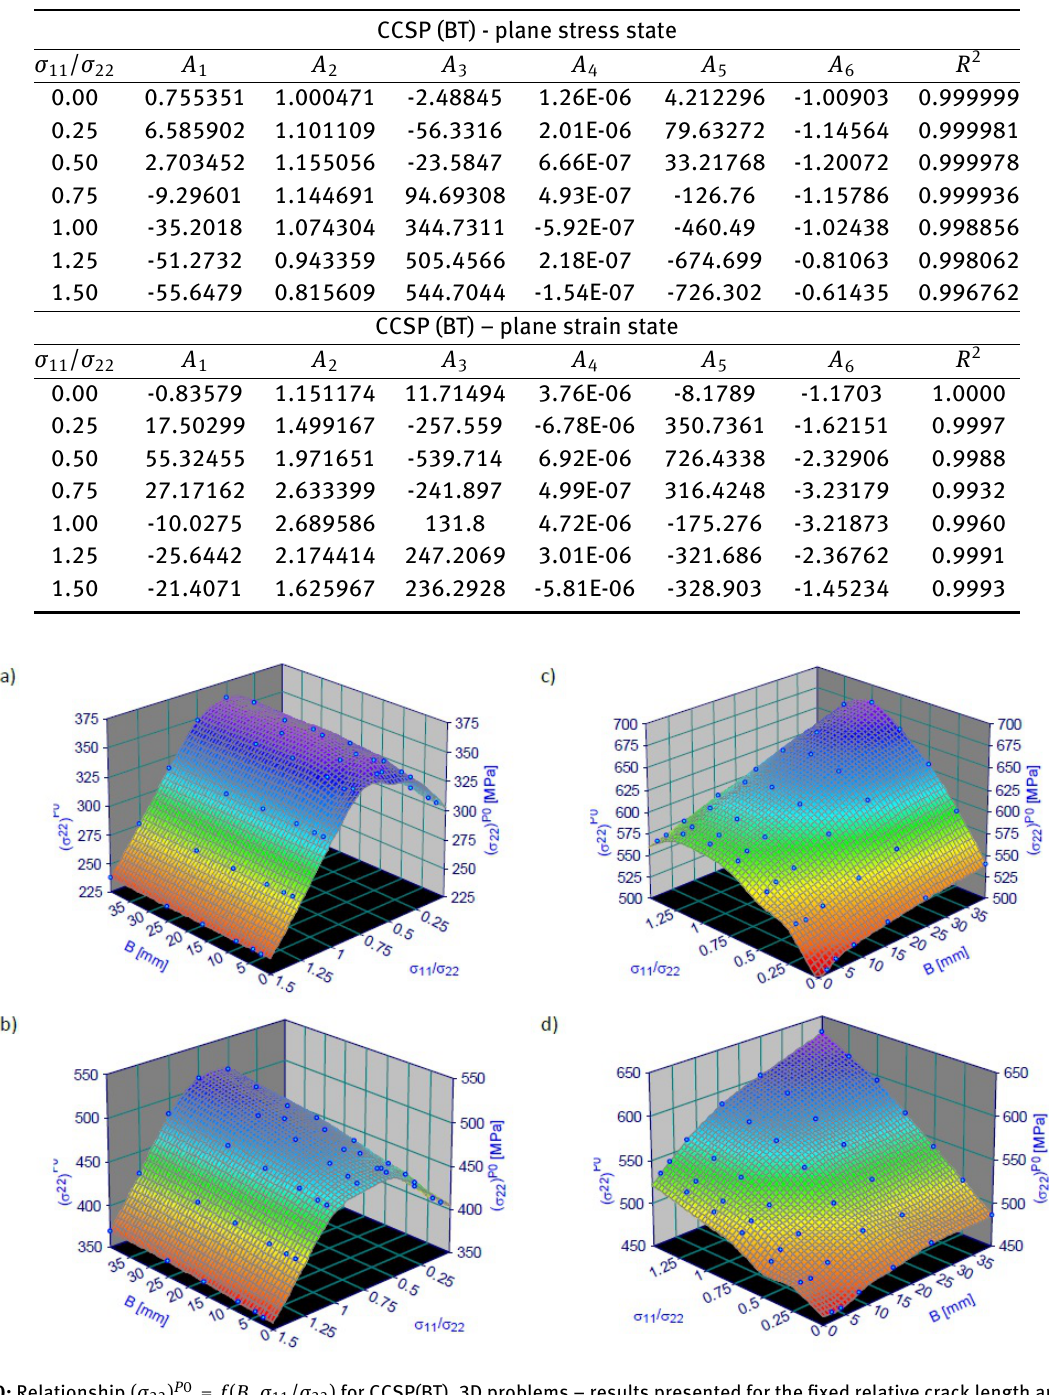
Table 8: Approximation coefficients for Eq. (4) required to estimate the limit load ( σ 22 ) P 0 for CCSP(BT) under conditions of predominant plane stress and plane strain.